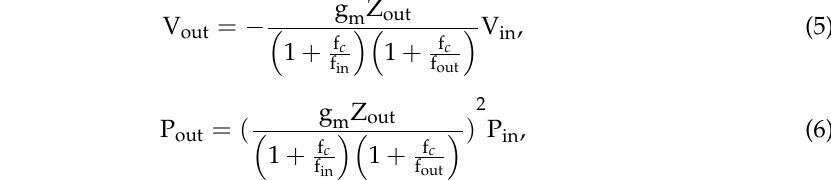
Figure 4. Schematic of the output matching network.